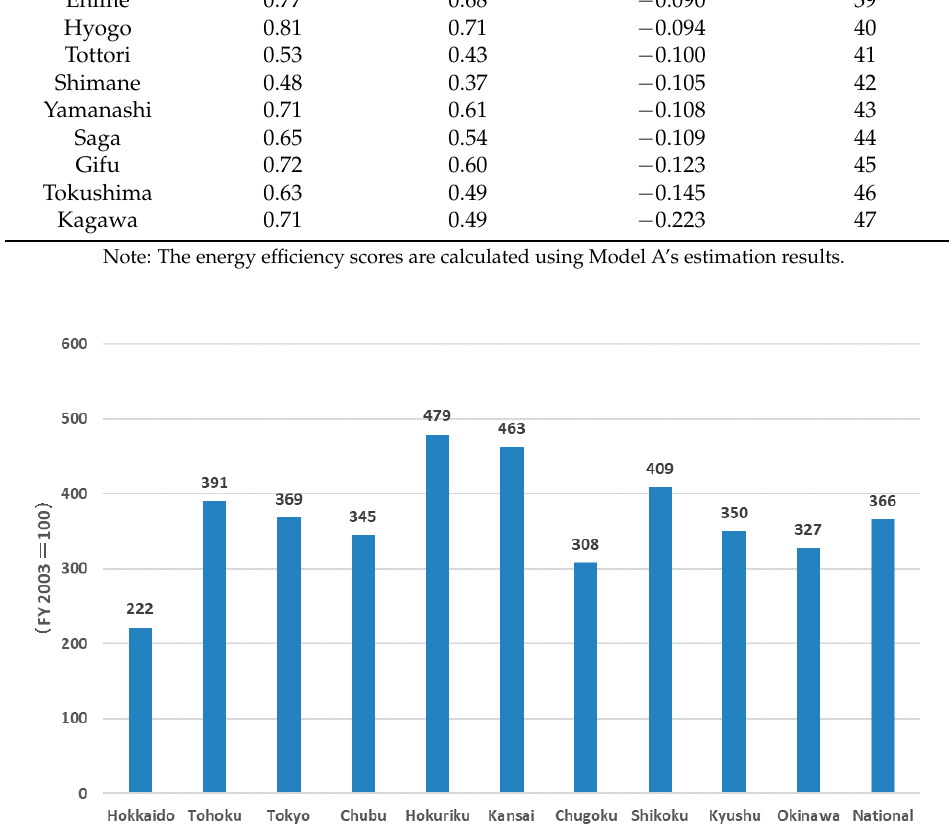
Figure 1. Changes in optional supply provision contracts by region. Source: Electricity Business